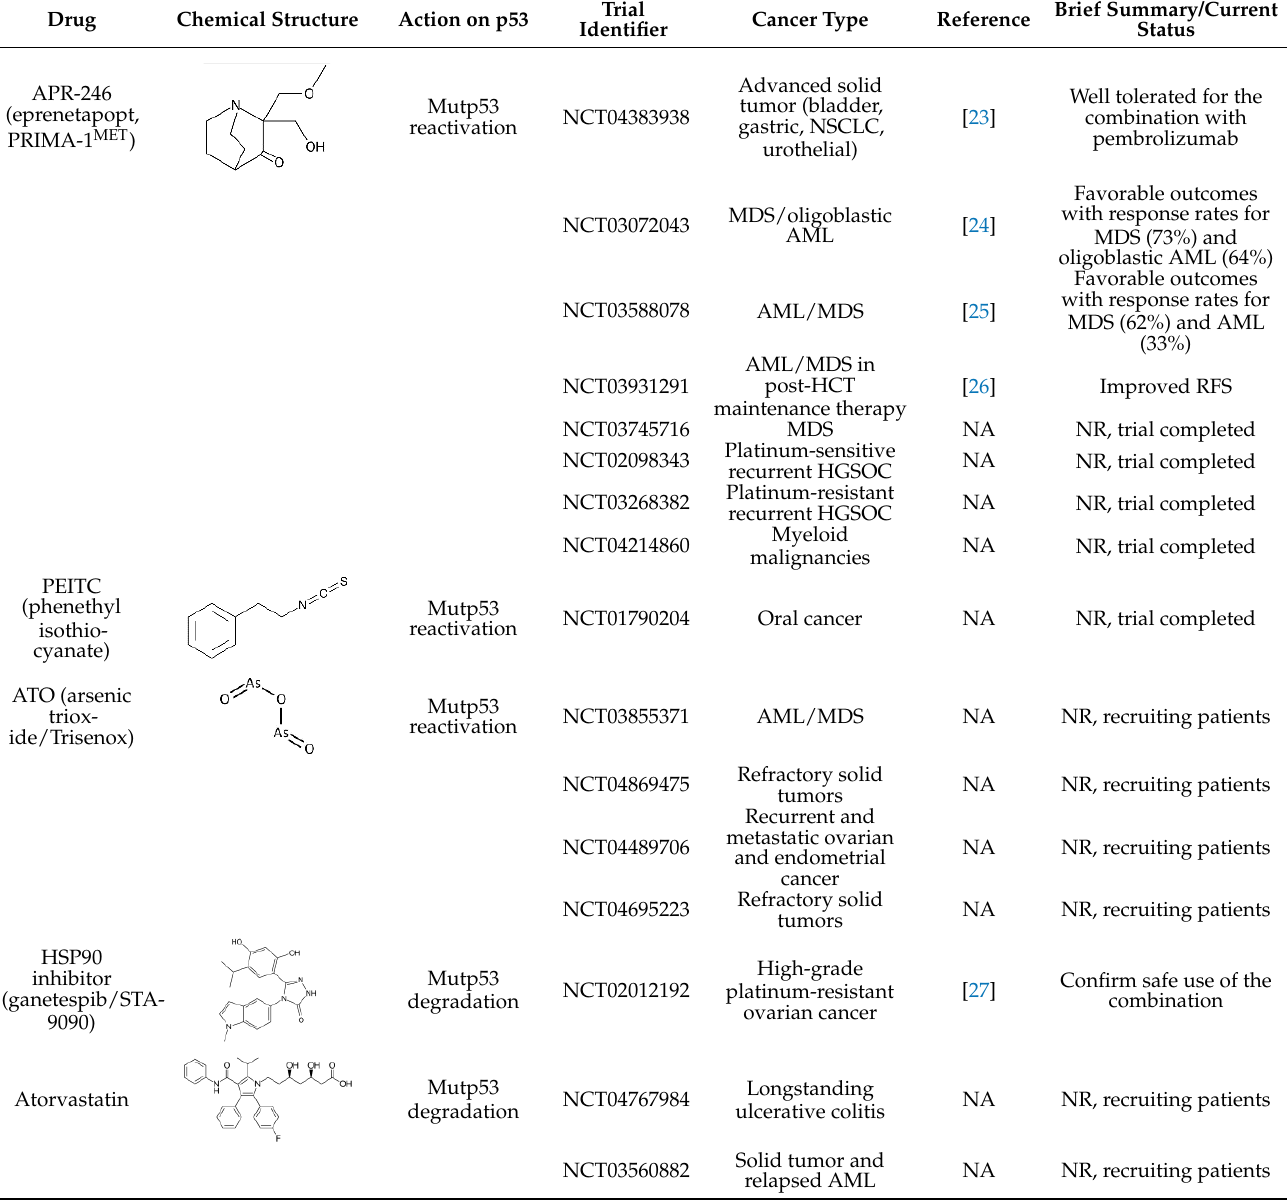
Table 1. Summary of drugs targeting p53 mutations.